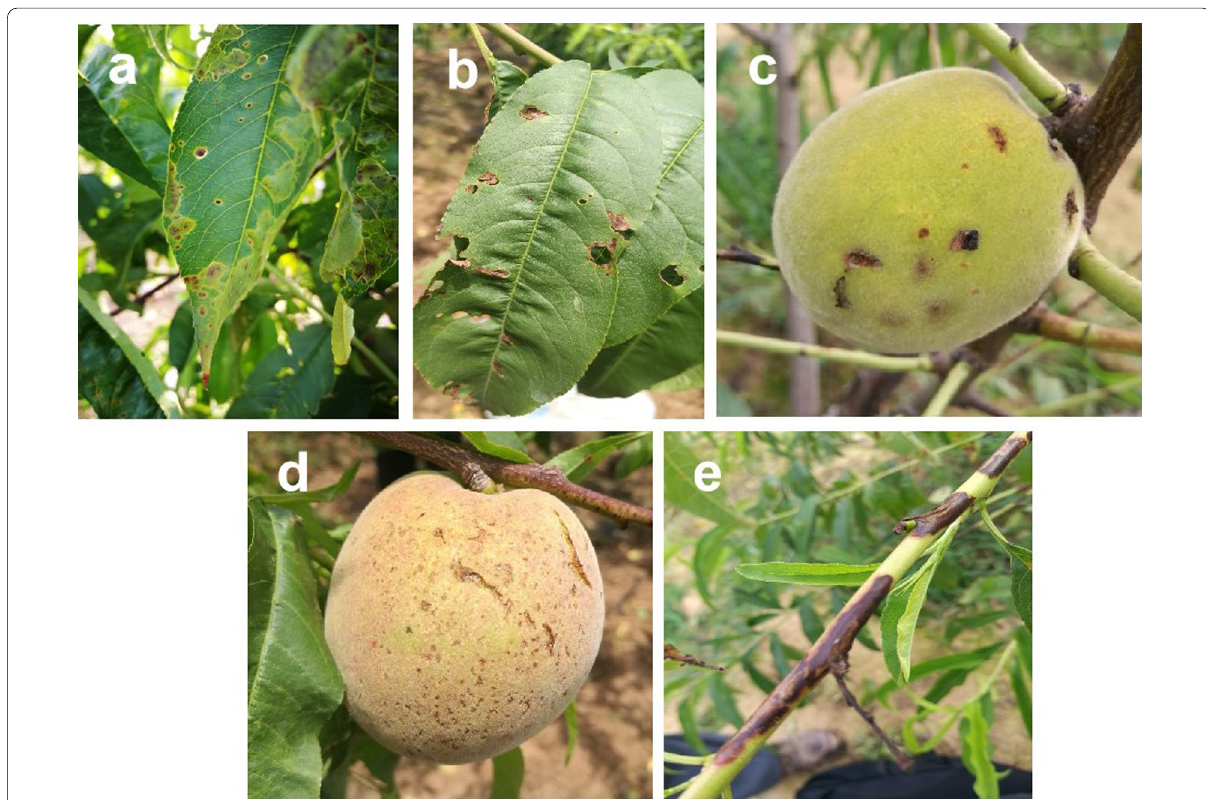
Fig. 2 Symptoms of peach bacterial spot. a Water‑soaked spots on leaf (Zaoyang, 2018). b Shot hole on leaf (Qujialing, 2017). c Large crater lesions and surface cracking on fruit (Xiaochang, 2017). d Shallow lesions on fruit (Qujialing, 2017). e Dark brown cankers on shoot (Xiaochang,